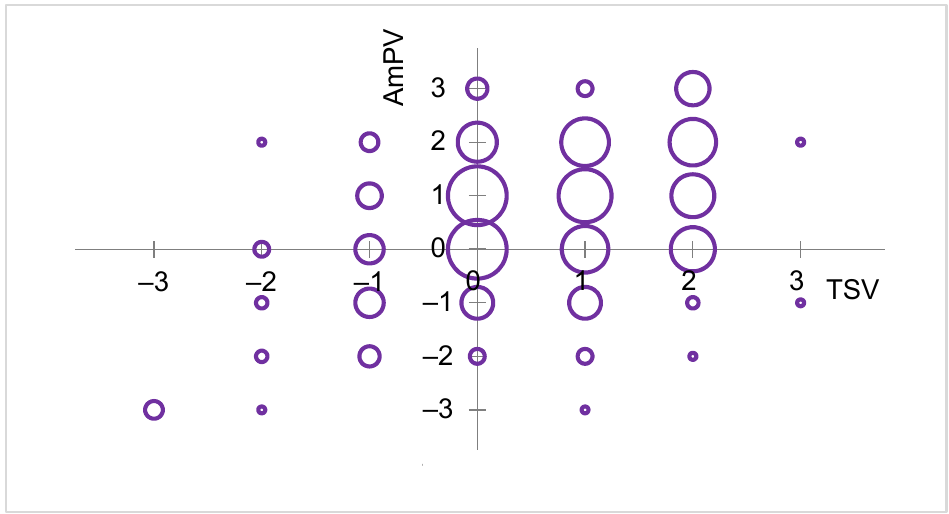
Figure 15. Relationship between TPV and AmPV.